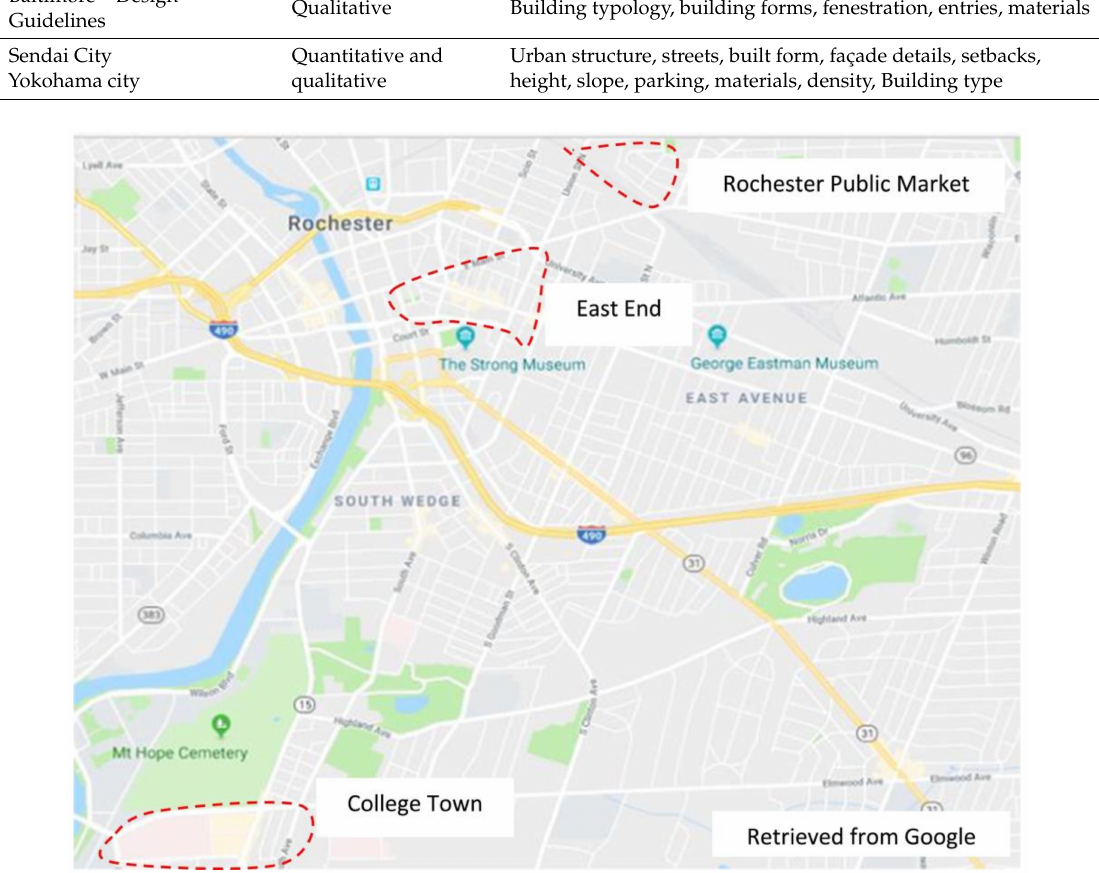
Figure 2. City map includes three sites